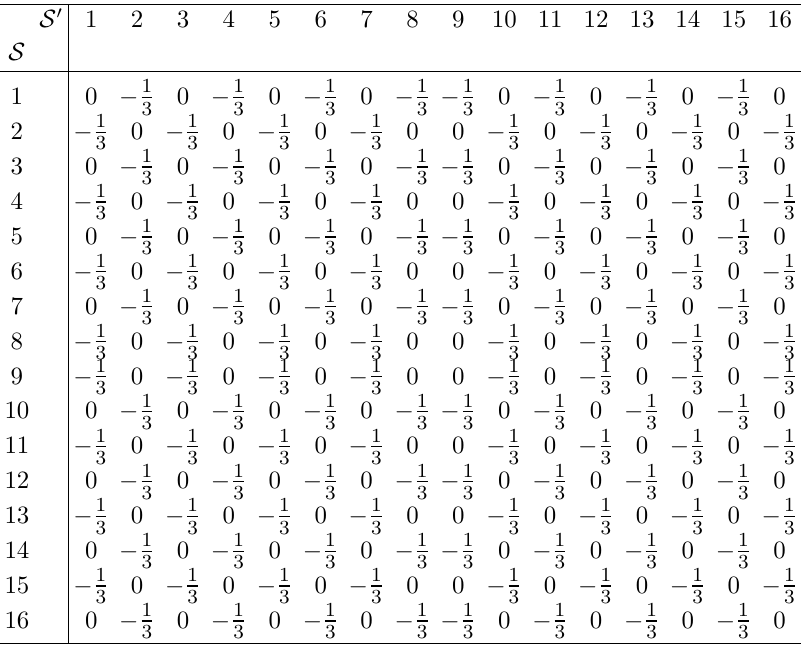
(cid:2) P with di(cid:11)erent boolean factors. [3] [5]